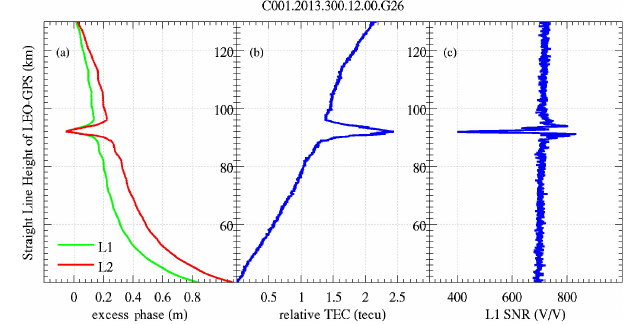
Figure 1. Straight line height variations of excess phase (a) , relative slant TEC (b) , and L1 SNR (c) of one selected radio occultation event observed by COSMIC FM1 on day 300 of 2013, when there was a sporadic E layer occurrence over the occultation